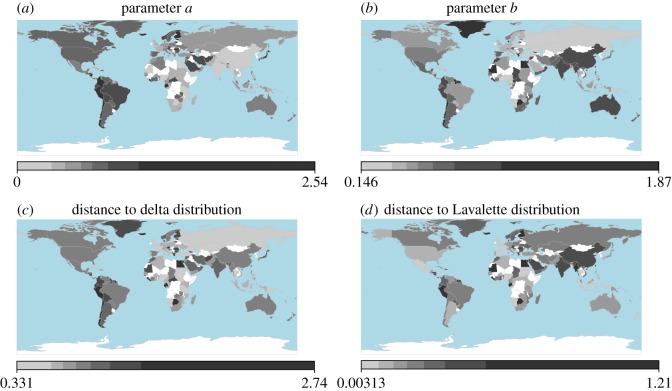
World maps of parameters and distances. (a) and (b) show the fitted a and b parameters, respectively, of the DGBD for the internal SAU population of each selected country and territory, (c) presents the Euclidean distance in the parameter plane 〈b,a〉 from a delta distribution in which all SAUs have the same population, and (d) shows the distance from a Lavalette distribution.